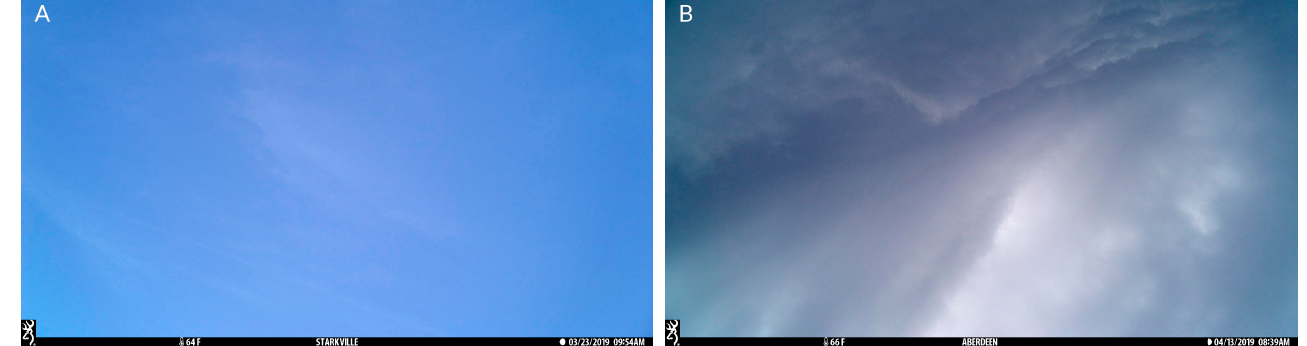
Figure 3. Example trail camera images showing ( A ) light cloud presence considered acceptable for acquiring aerial images using UAS; and ( B ) dense cloud presence considered unacceptable for acquiring aerial images using UAS due to the attenuated radiation and potential for uneven lighting of reflective